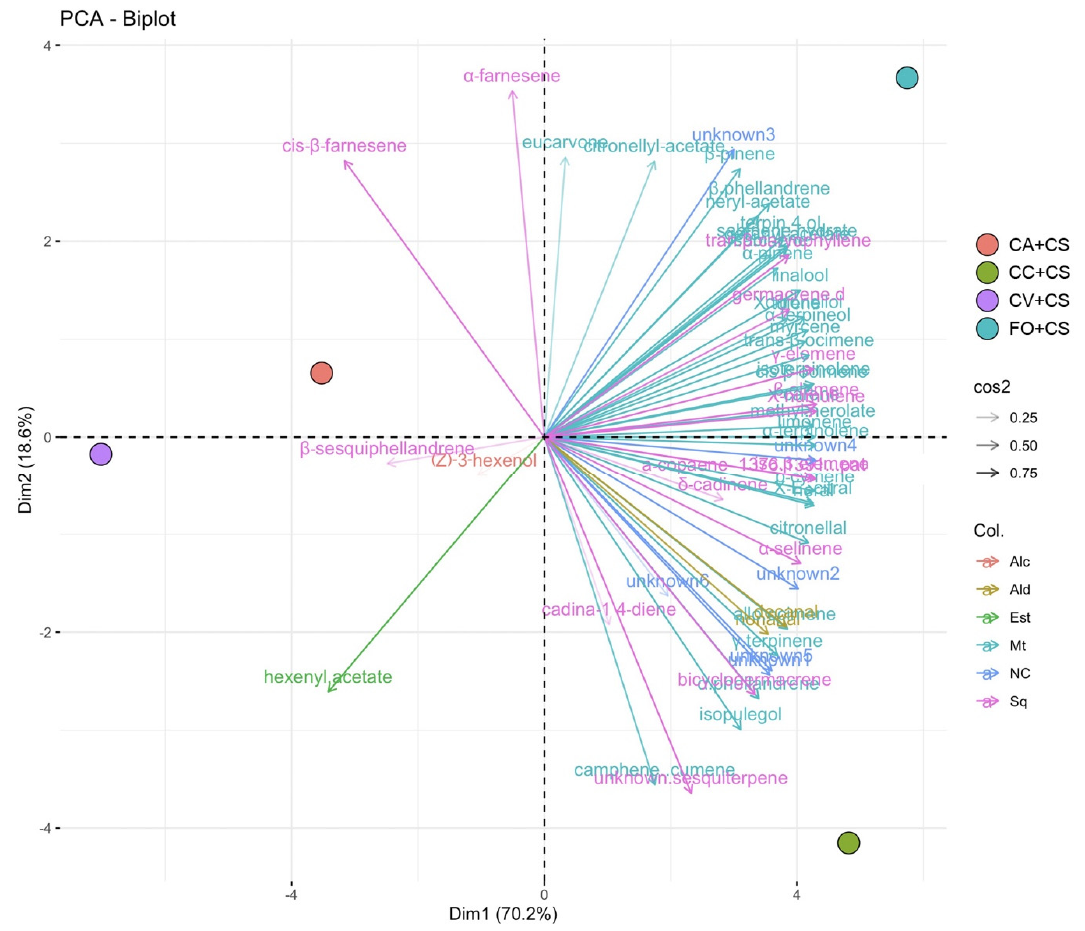
Figure 2. Biplot of the principal component analysis (PCA) for VOC profiles detected on leaves of Citrus sinensis grafted on four rootstocks showing different susceptibilities to CTV infection. Based on their profiles, samples were organized in four groups, and the associated compounds to varieties separation are indicated by vectors in the plot, underlining their significance values (0.25 < cos2 < 0.75). Each main category is highlighted with a different color: alcohol (Alc), aldehydes (Ald), esters (Est), monoterpene (Mt), and sesquiterpene (Sq). NC: not classified—unknown. CS: Citrus sinensis ; CV: Volkamer lemon; FO: Forner-Alcaide no. 5; CC: Carrizo citrange; CA: Citrus aurantium